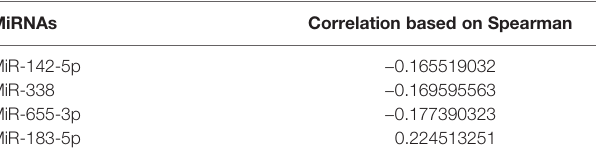
TABLE 3 | The miRNAs targeting GOLPH3 in lung adenocarcinoma. MiRNAs Correlation based on Spearman FDR (BH)